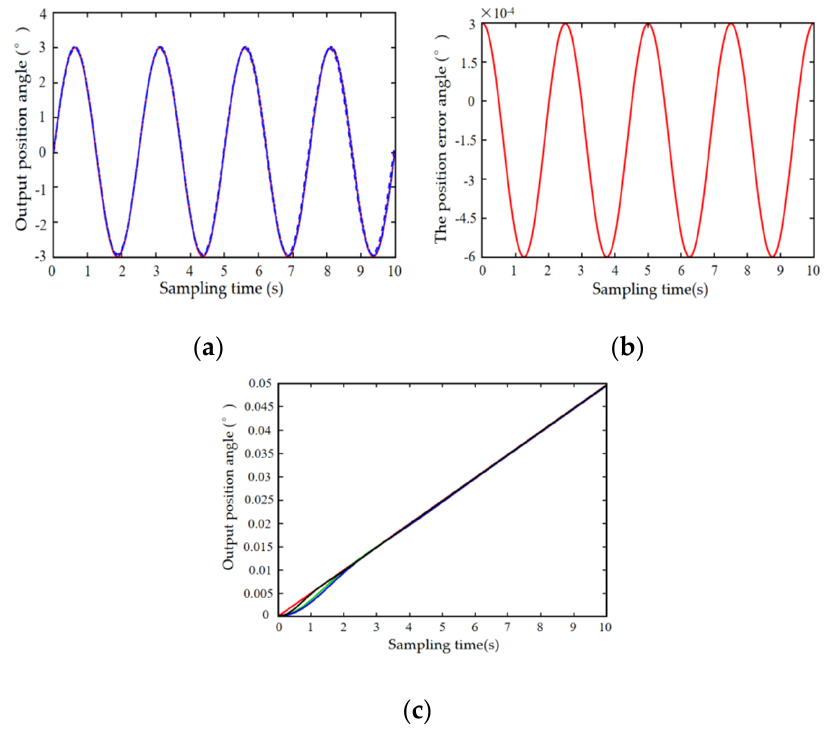
Figure 10. LuGre model simulation control result. ( a ) Sin position output under compensated control by the LuGre friction model that offers piecewise parameter identification by GA-PSO; ( b ) Position error under compensated control by the LuGre friction model that offers piecewise parameter identification by GA-PSO; ( c ) Angular position output curve under compensated control by the LuGre friction model that offers identification of three kinds of algorithms.